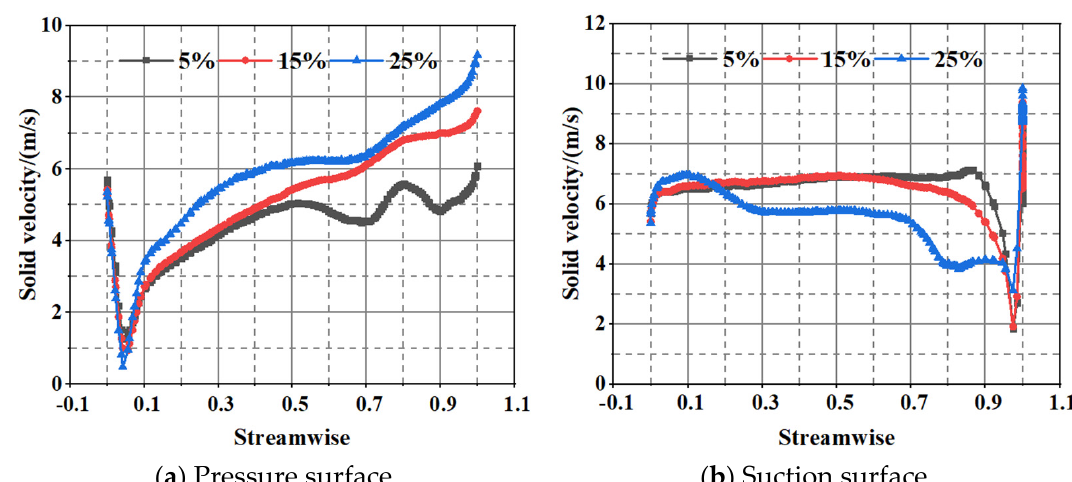
Figure 10. ( a , b ) Solid velocity distribution of the blade.